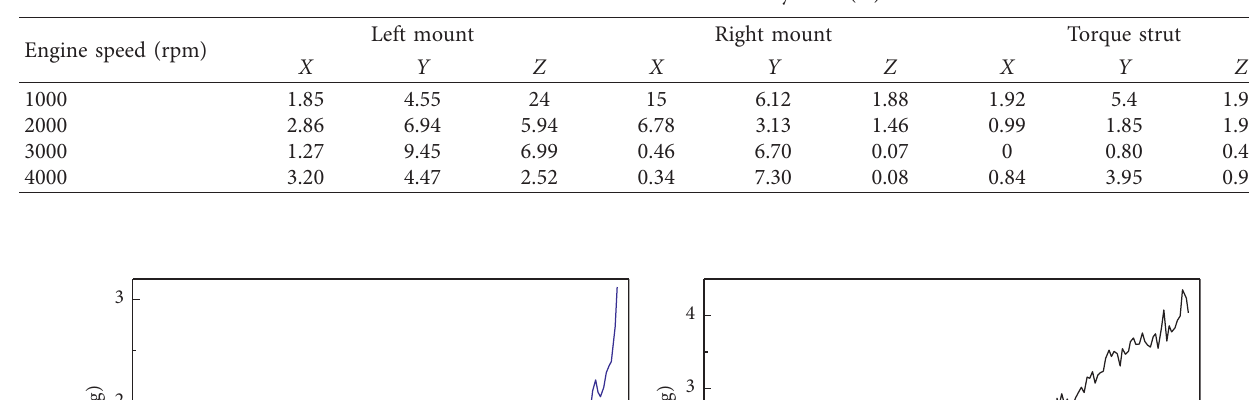
Table 5: The second-order transmissibility ratio (%).